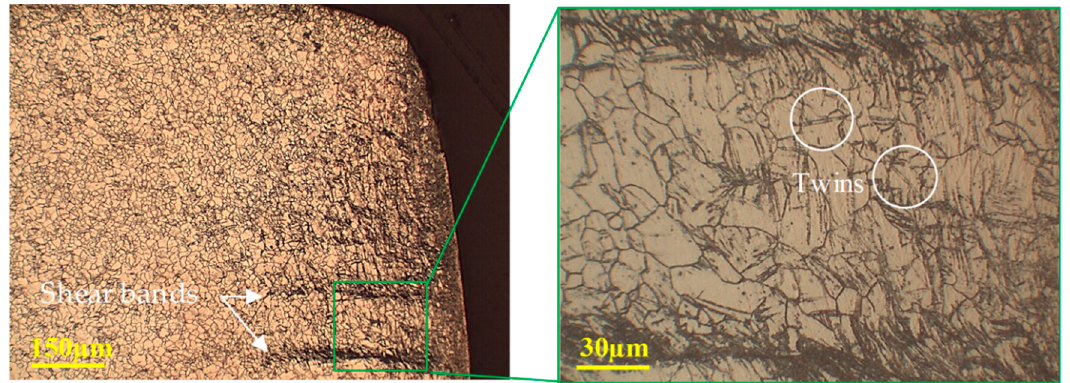
Figure 19. Optical microstructure of the shear zone at 25 °C and 20% clearance, illustrating shear bands and twinning at the sheared edge.